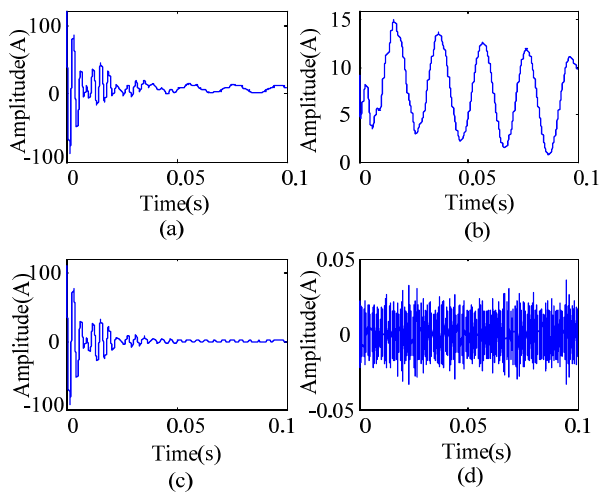
Figure 2. VMD decomposition results with use of ideal transient zero-sequence current (TZSC). ( a ) Ideal TZSC; ( b ) intrinsic mode function (IMF)1; ( c ) IMF2; ( d ) IMF3.